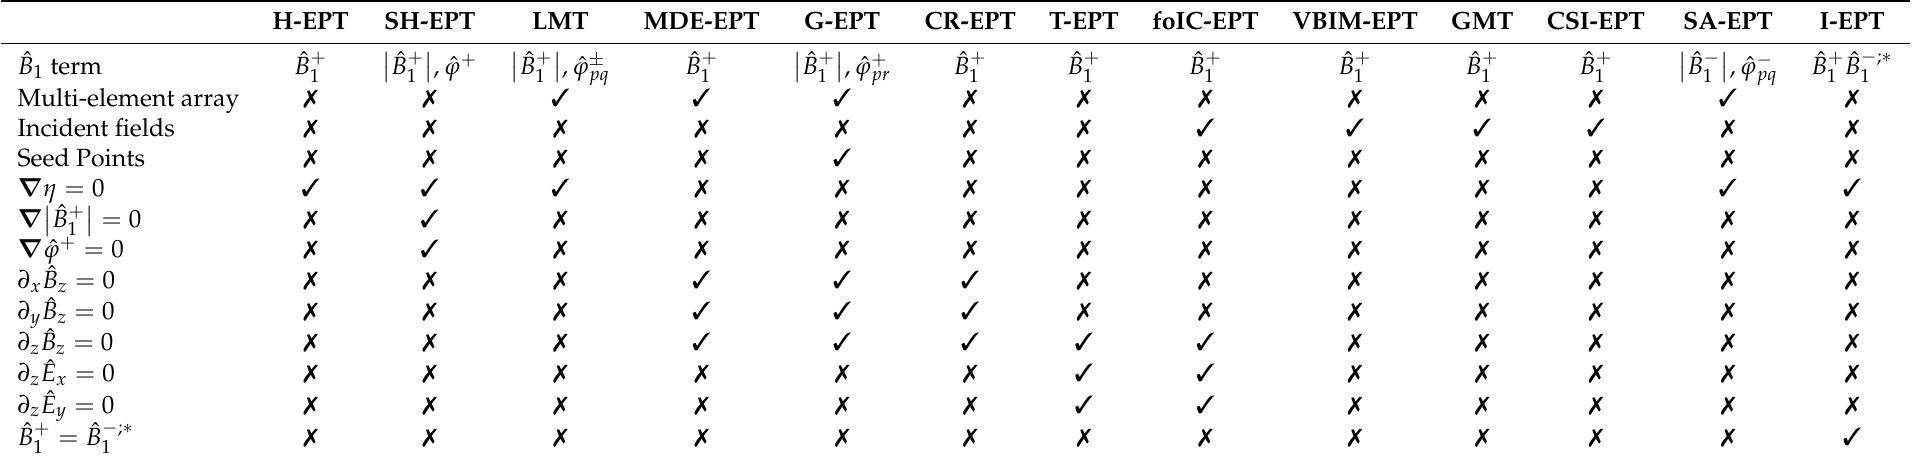
Differential (order) Local Direct (backward) Forward (indirect) Table 2. Data requirements for the EPT approaches as described in this manuscript. Note that data requirements can be influenced by extensions or generalizations of the methods.